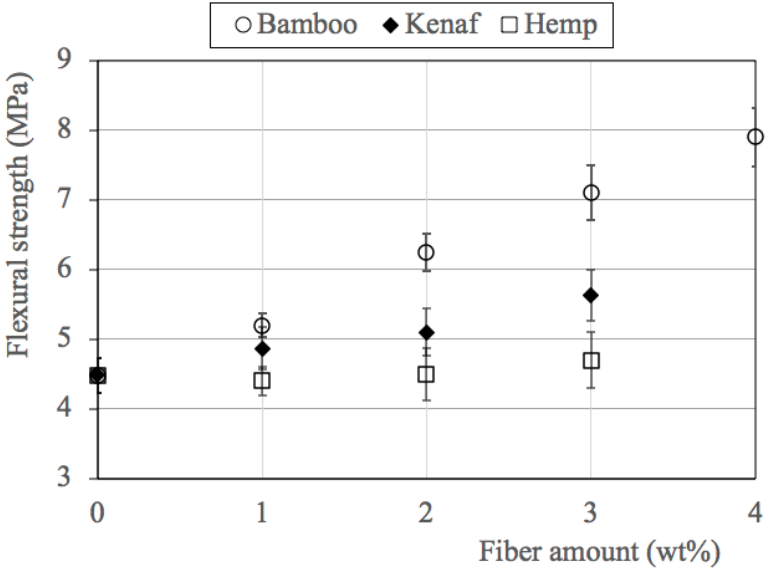
Figure 5. Flexural strength of the investigated materials.